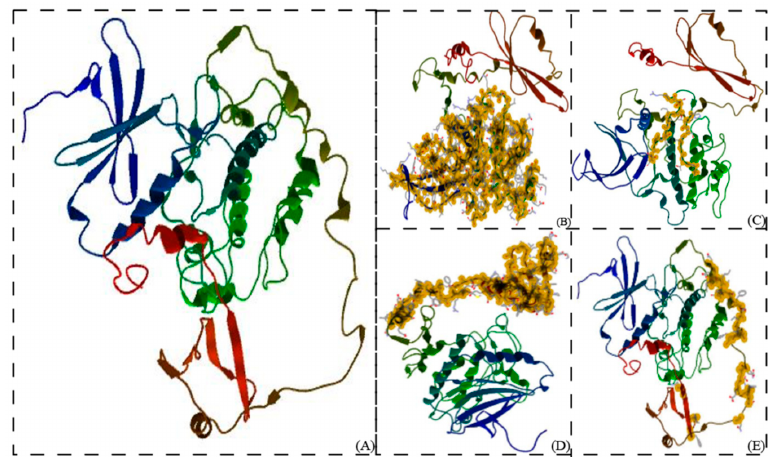
Figure 5. Protein structure of Lla CIPK predicted by I-TASSER server (https://zhanglab.ccmb.med.umich.edu/I-TASSER/): Lla CIPK regions were highlighted by selecting amino acid residues with CLC genomics workbench v11.0. ( A ) Predicted Lla CIPK protein structure. ( B ) N-terminal catalytic domain (Serine/Threonine Kinase domain) of Lla CIPK (selected amino acids). ( C ) Activation loop (A-loop) of Lla CIPK (selected amino acids). ( D ) C-terminal regulatory domain of Lla CIPK (selected amino acids) (E) CBL interaction site (polypeptide binding site) Lla CIPK (selected amino acids).